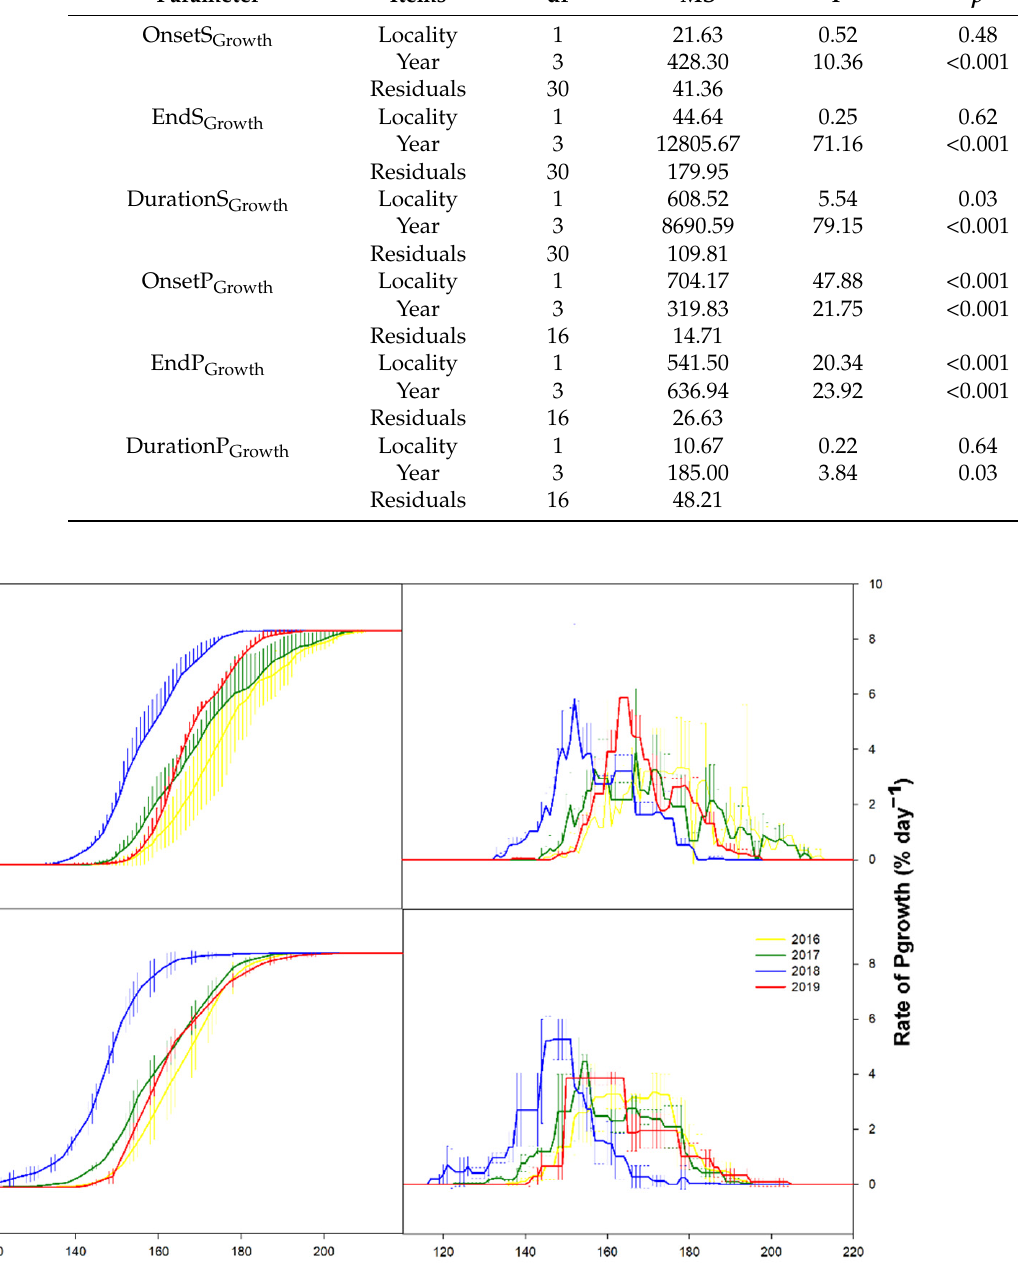
Table 2. The summary of general linear model for onset, end and duration of primary growth (P growth ) and secondary growth (S growth ) at ESP Rajec and Bily Kriz in different years (2016 – 2019).